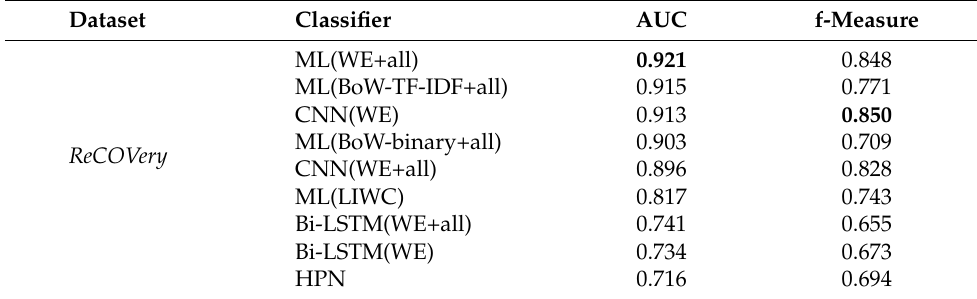
Table 5. Global evaluation results for the ReCOVery